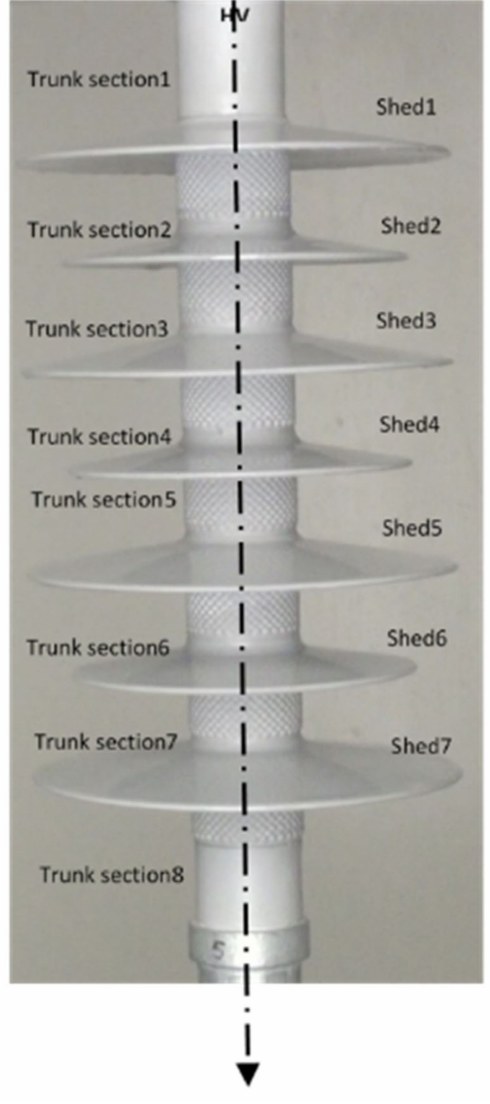
Figure 5. Photo of the used